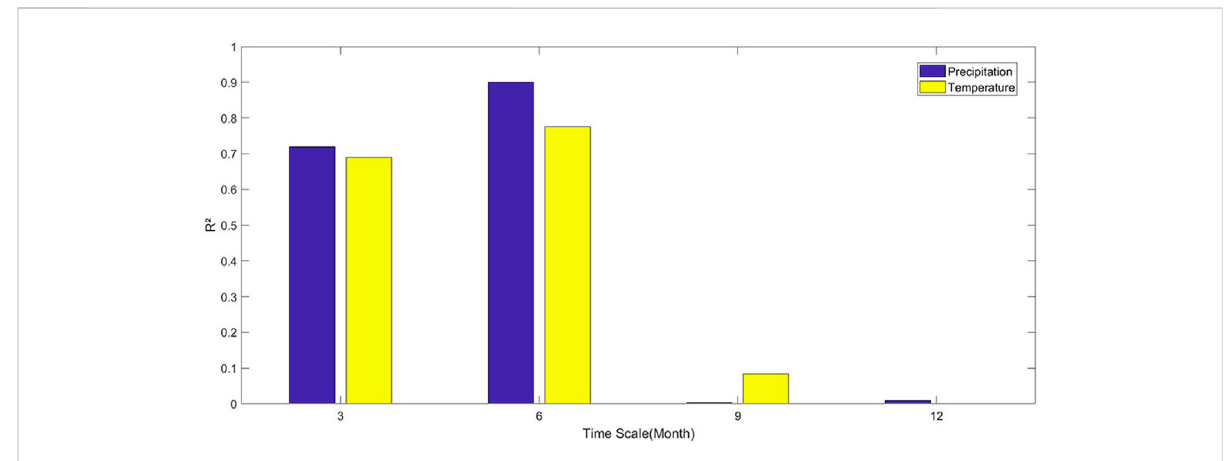
FIGURE 10 The Determination coef fi cient ( R 2 ) of the linear regression model between the propagation time and temperature and